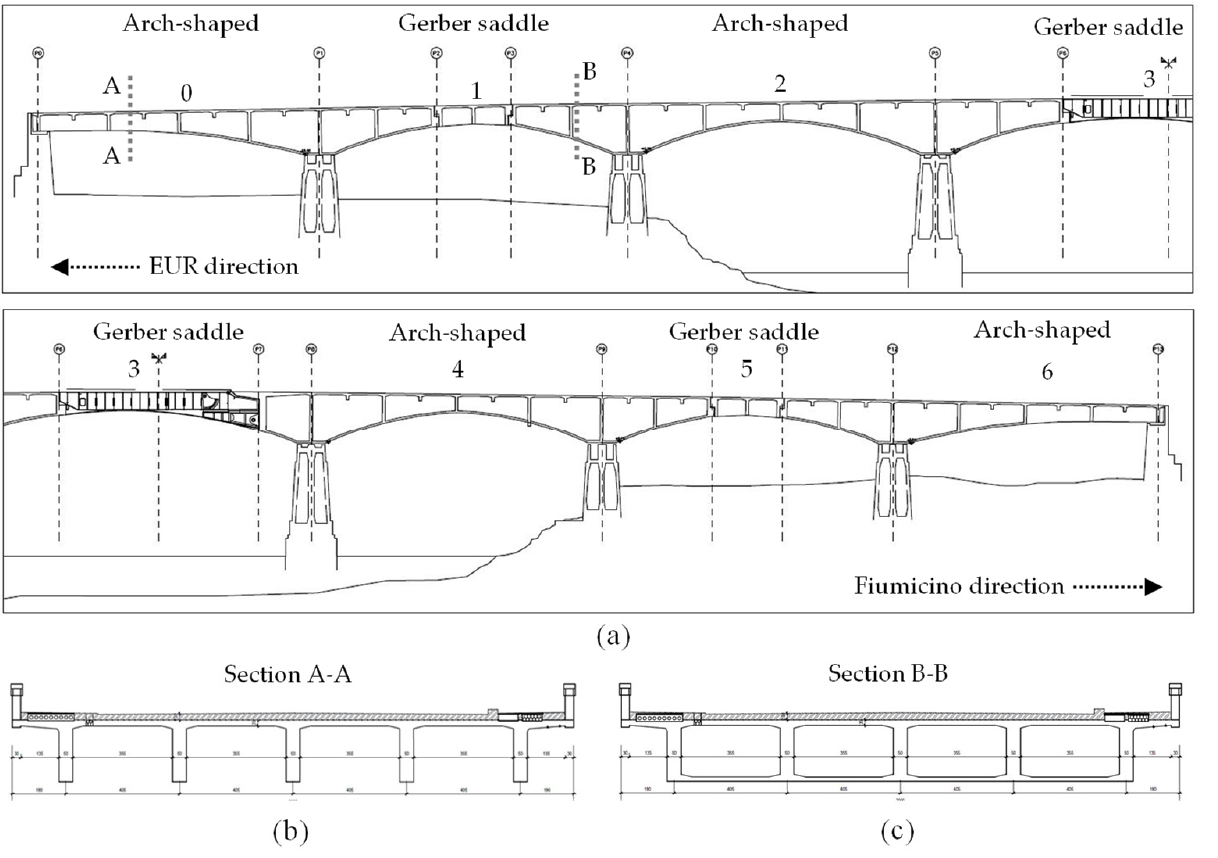
Figure 5. ( a ) Half left ( above ) and half right ( below ) lateral section of the bridge. Highlights of the span typologies: alternation between arch-shaped and Gerber saddles. ( b , c ) Two types of transversal sections: ( a ) open profile and ( b ) multi-connected.